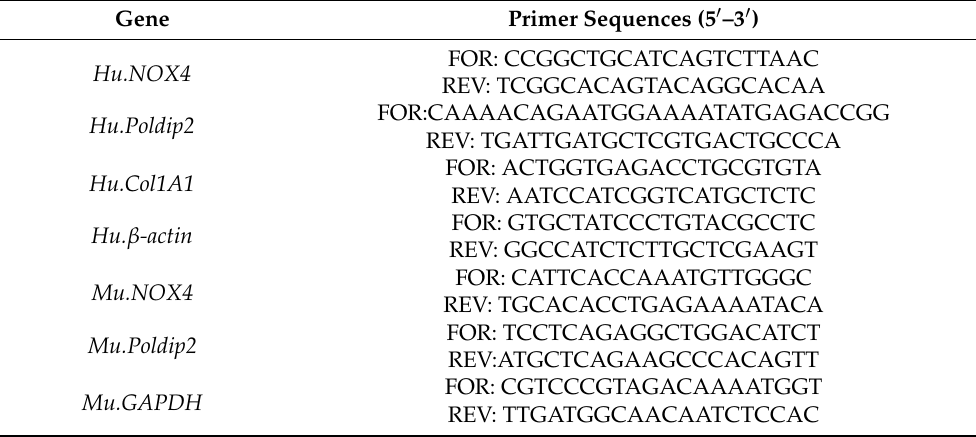
Table 1. Human and mouse sequences and accession numbers for primers (forward, FOR; reverse, REV) used in RT-PCR.